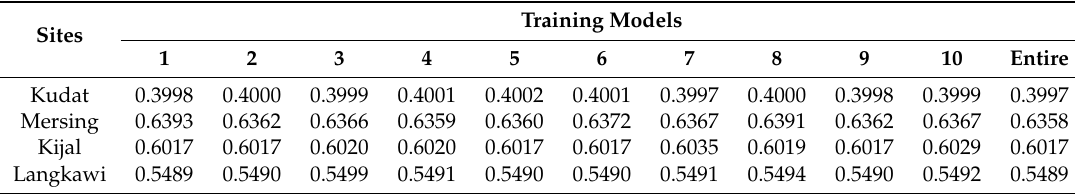
Table 6. The RMSE for every training models.